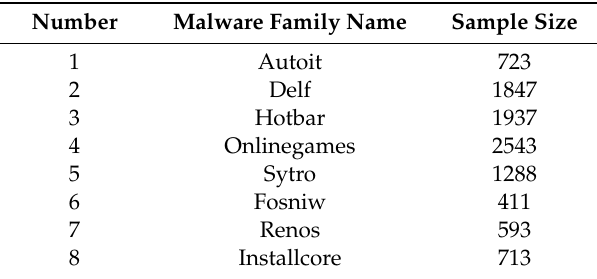
Table 3. The malware sample dataset (2).